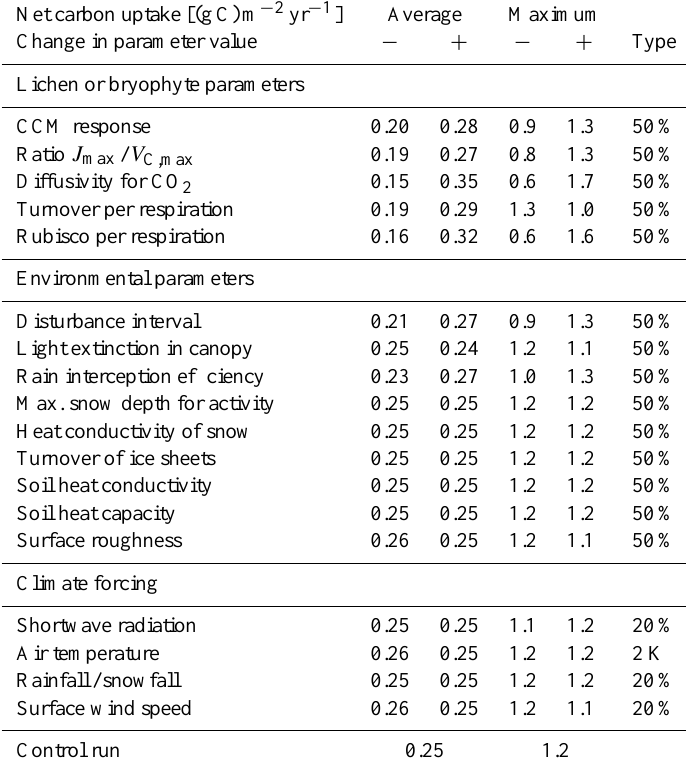
Table 2. Influence of uncertain model parameters on simulated net carbon uptake. “Average” and “maximum” correspond to two different weighting methods for the results (see Sect. 2.3). The “ + ” signs denote an increase in the value of a parameter and “ − ” signs denote a decrease. The rightmost column shows the type of increase or